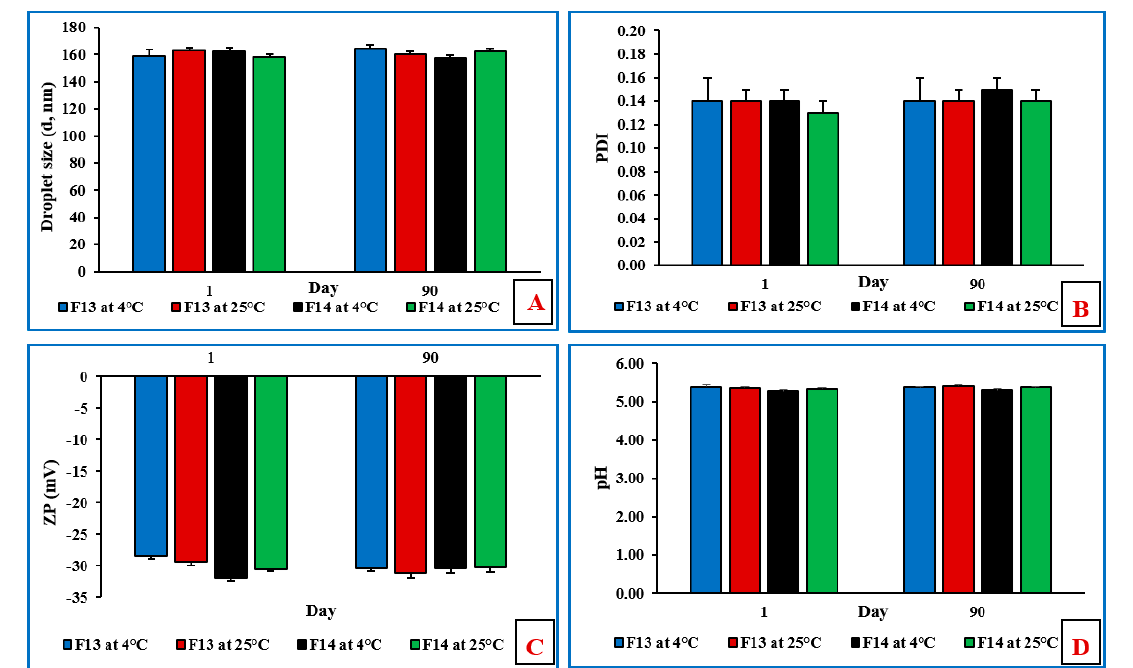
Figure 5. ( A ) Droplet size, ( B ) polydispersity index, ( C ) zeta potential, and ( D ) pH of F10 formula- tion over three months of storage at 4 °C, 25 °C, and 40 °C (mean ± SD, n =3).